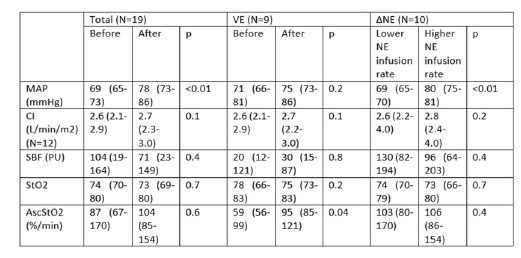
Table 1 (abstract 001108). See text for